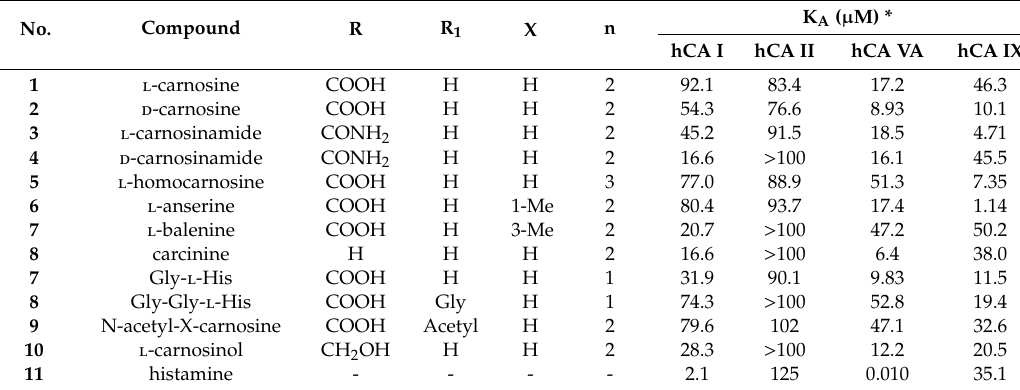
Table 1. Considered carnosine derivatives 1 – 10 and their CA activating properties against human CA isoforms hCA I, II, VA and IX, by a stopped-flow CO 2 hydrase assay. Histamine 11 was used as reference standard